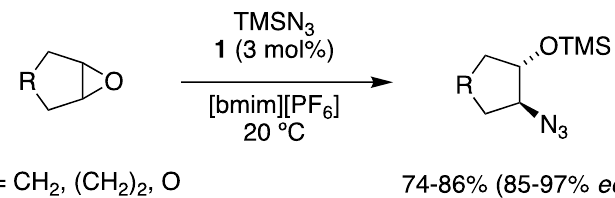
Figure 11. 1-Butyl-3-methylimidazolium salts.